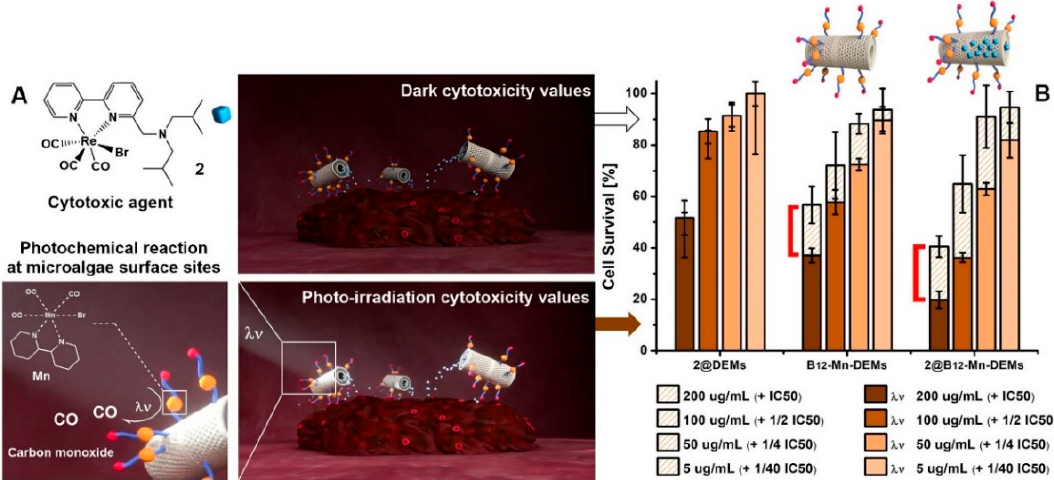
Figure 6. ( A ) Conceptual representation of the experiment, structure of complex 2 and detail of the photochemical reaction taking place at the microalgae surface sites (CO release from Mn complex). ( B ) Histograms representing the effects on HCT-116 colorectal cancer cells % survival by different doses of 2 @DEMs, B 12 -Mn-DEMs and 2 @B 12 -Mn-DEMs when administered in the dark (empty bars) and under the same conditions following light activation of the microalgae surface (filled colored bars). The red square brackets on the graph are meant to highlight the enhanced cytotoxicity of the material upon photo-irradiation.